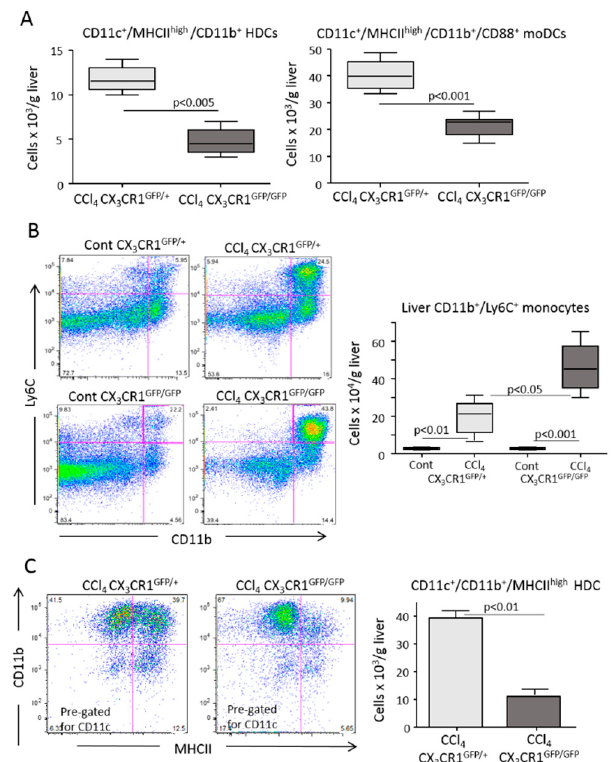
Figure 4. The lack of CX 3 CR1 reduced the di ff erentiation of monocyte-derived dendritic cells (moDCs) in response to liver inflammation. The liver distribution of CD11b + myeloid dendritic cells, moDCs and monocytes were analyzed by flow cytometry in the livers of CX 3 CR1 gfp /+ and CX 3 CR1 gfp / gfp mice 36 h after receiving an acute dose of CCl 4 . ( A ) The prevalence of CD11c + / MHCII high / CD11b + myeloid dendritic cells and CD11c + / MHCII high / CD11b + / CD88 + moDCs in CX 3 CR1 gfp /+ and CX 3 CR1 gfp / gfp mice receiving CCl 4 . ( B ) Hepatic distribution of Ly6G − / CD11b high / Ly6C high monocytes in control and CCl 4 -treated CX 3 CR1 gfp /+ and CX 3 CR1 gfp / gfp mice. ( C ) Impaired expression of MHCII by CD11c + / CD11b + myeloid cells in CCl 4 -treated CX 3 CR1 gfp /+ and CX 3 CR1 gfp / gfp mice. The values are expressed as means ± SD of three di ff erent cell preparations or 5–6 animals.